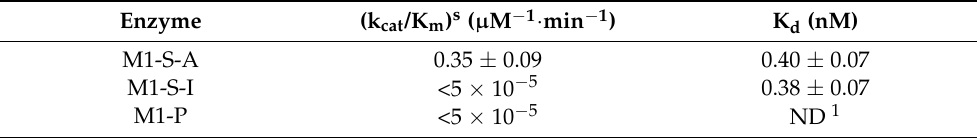
Table 1. RNase P ribozyme cleavage of substrate s37 (overall cleavage rates ((k cat /K m ) s ) and binding dissociation constants (K d )). Experimental details are described in Material and